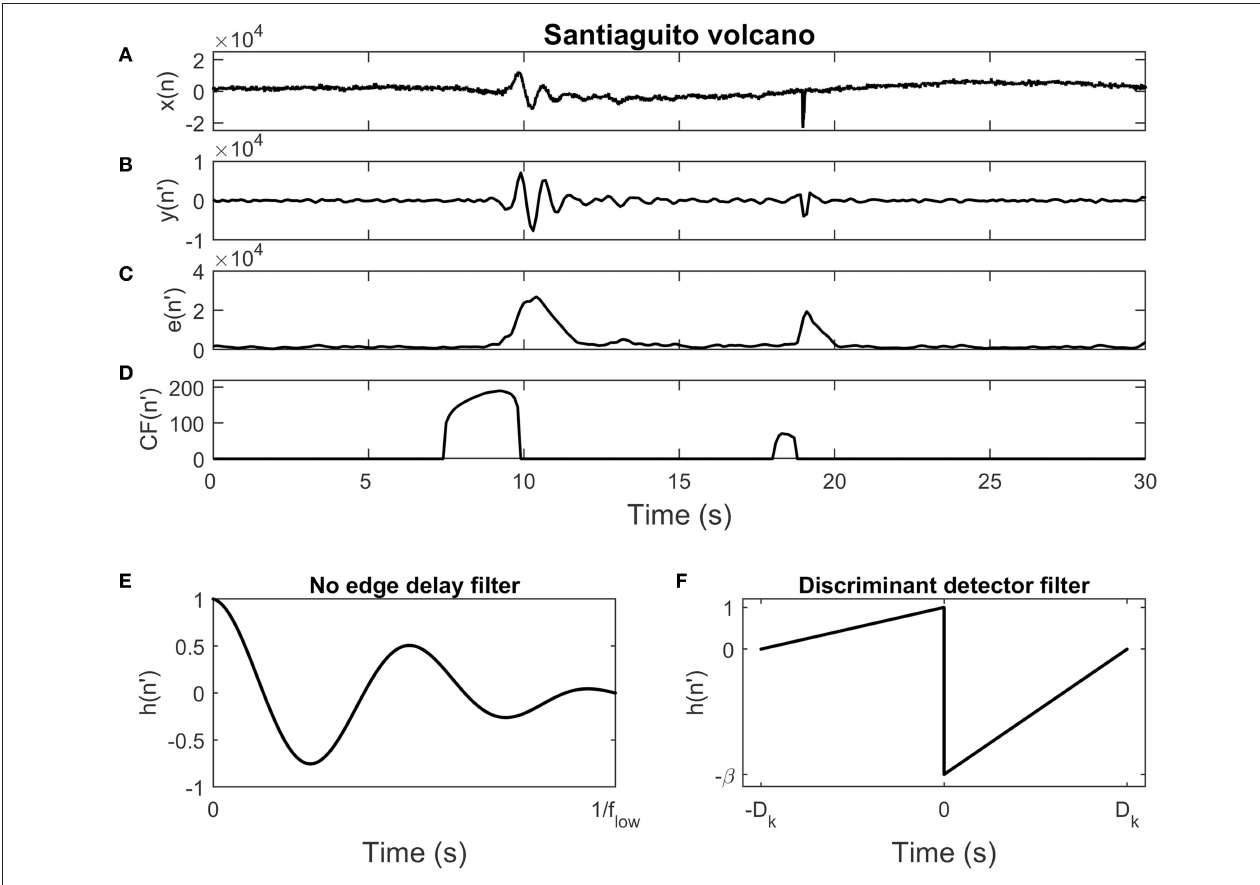
FIGURE 2 | Output example for all intermediate steps of the VINEDA workflow. (A) The original infrasound signal of an explosion at Santiaguito volcano, Guatemala, x ( n ). (B) The signal y ( n ′ ) is the output after decimation, detrending and median filtering stages. (C) The signal e ( n ′ ) represents the output of the no edge delay filter bank. (D) A characteristic function CF ( n ′ ) is obtained from the signal, which can be used to perform the automatic detection. (E) Example of the impulse response of the bandpass filters. (F) Impulse response for the proposed discriminant detector (Álvarez et al.,